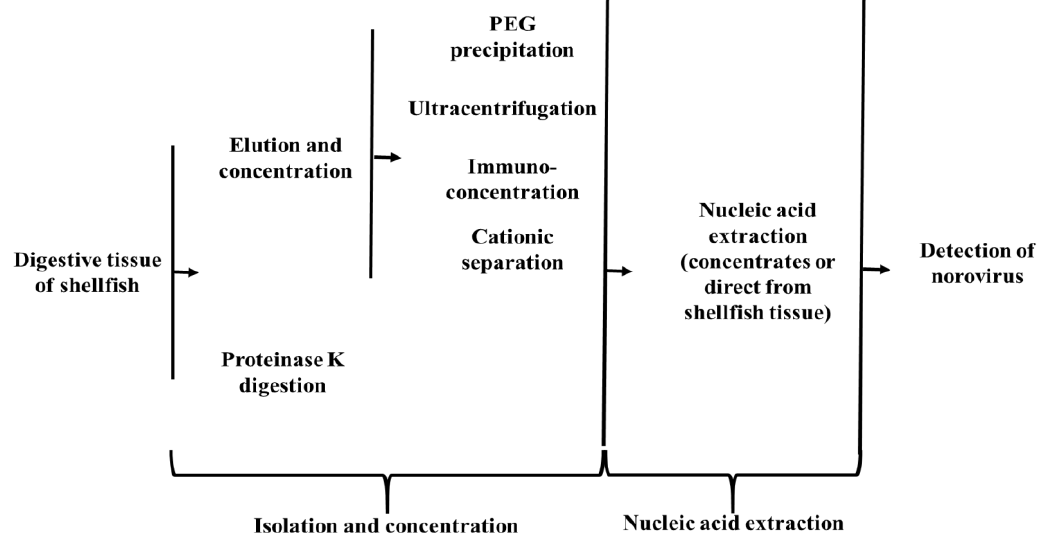
Figure 1. A flow diagram of current approaches to isolate, concentrate and detect norovirus from shellfish.